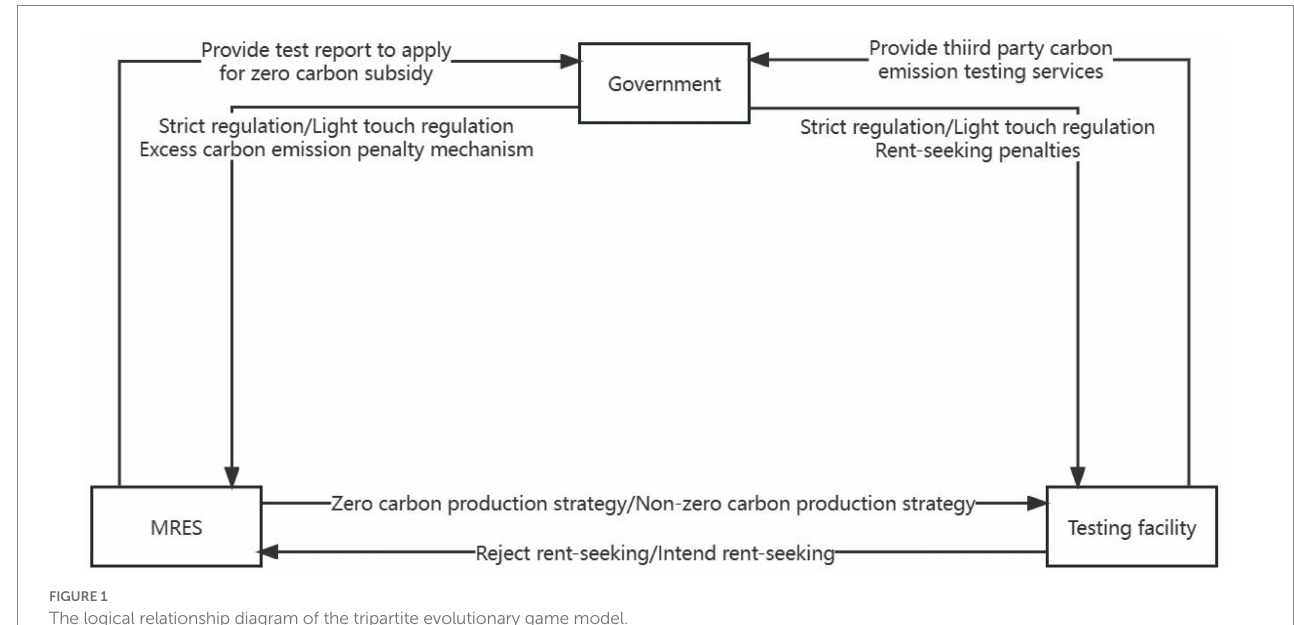
FIGURE 1 The logical relationship diagram of the tripartite evolutionary game